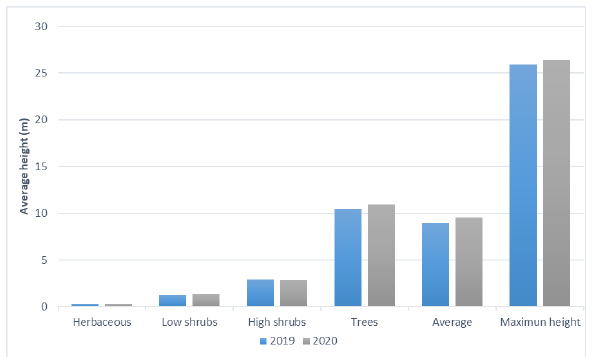
Figure 7 . Average height stratums